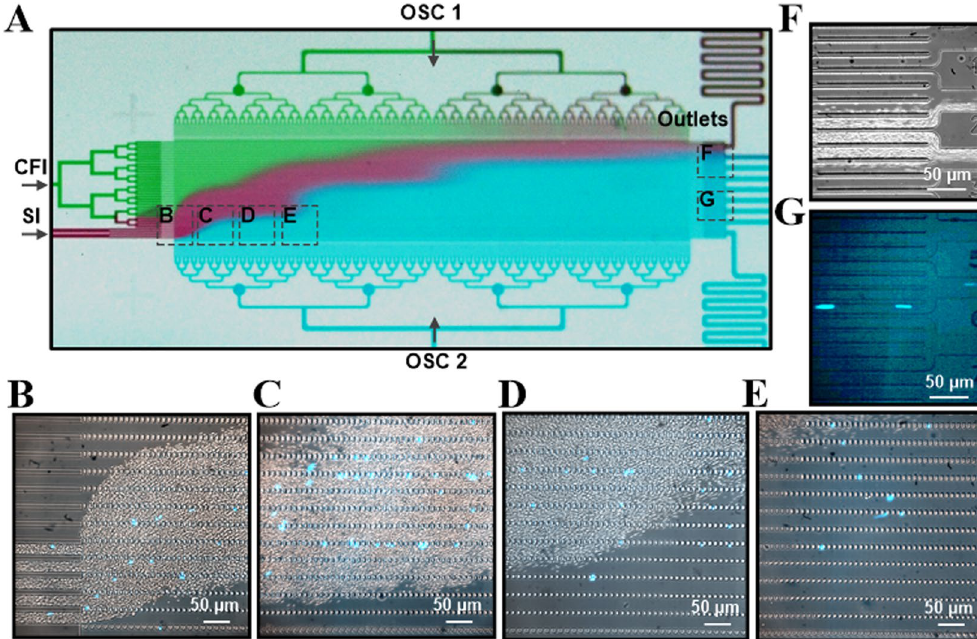
Figure 2. Microfluidic ratchets to separate leukocytes directly from whole blood. ( A ) Image of the sorting region of microfluidic ratchets infused with food color dyes illustrating the diagonal trajectory of the sample inlet flow. ( B–E ) Images of the leukocytes stained with Hoechst 33342 being separated from the whole blood and traversing diagonally through the funnel matrix. ( F , G ) Bright field and fluorescence images of the outlets showing the separate reservoirs into which RBCs and leukocytes are